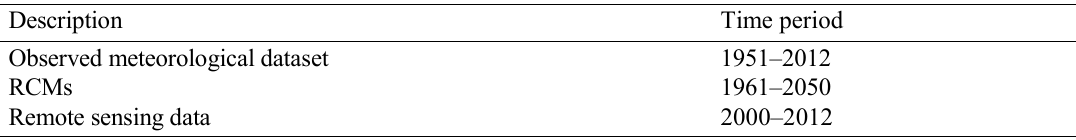
Table 1 Time periods of